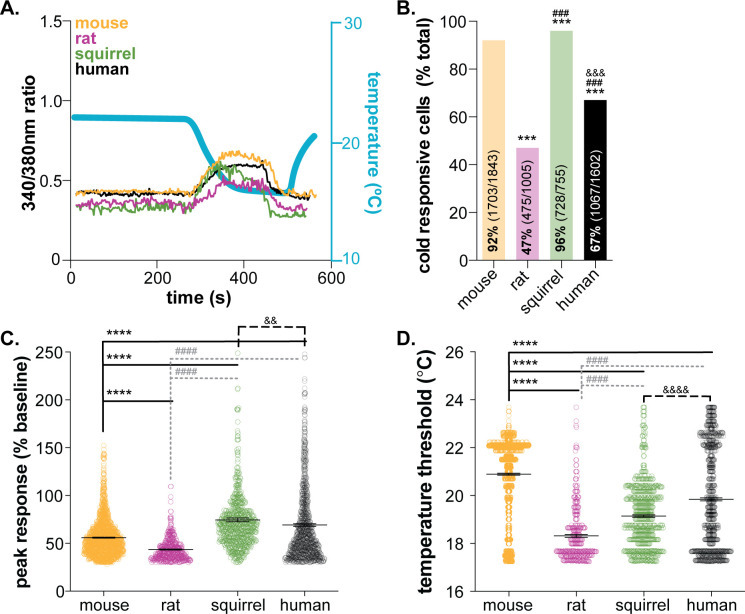
Mammalian keratinocytes respond to temperature decreases.In vitro calcium imaging was performed on primary cultured keratinocytes from the glabrous hindpaw skin of C57BL/6 mice, Sprague Dawley rats, and 13-lined ground squirrels and human breast skin. (A) Representative keratinocytes from all species exhibited a calcium transient upon extracellular buffer cooling (~23°C to 12°C). (B) The greatest proportion of cold-responsive cells was observed in hibernating 13-lined ground squirrel samples. The vast majority of mouse keratinocytes also responded to decreasing temperatures; fewer rat and human keratinocytes responded to cold (Chi-square p<0.0001; Fisher’s Exact tests: ***p<0.001 vs. mouse; ### p<0.001 vs. rat; &&& p<0.001 vs. squirrel; n = 28 mice, four rats, four squirrels, five humans). (C) The peak calcium response to decreasing temperatures varied between species; hibernating 13-lined ground squirrel keratinocytes exhibited the largest calcium transients (75% increase over baseline) and Sprague Dawley rats exhibited the smallest (44% increase over baseline; mouse: 56% increase; human: 69% increase; 1-way ANOVA p<0.0001; Bonferroni’s multiple comparisons: ****p<0.0001 vs. mouse; #### p<0.0001 vs. rat, && p=0.0084 vs. squirrel). (D) The temperature at which keratinocytes responded to cold (>30% increase in Δ340/380) differed between species. Mean temperature thresholds (°C) for mouse: 20.9, rat: 18.3, squirrel: 19.1, human: 19.8 (Kruskal-Wallis test p<0.0001; Dunn’s multiple comparisons: ****p<0.0001 vs. mouse, #### p<0.0001 vs. rat, &&&& p<0.0001 vs. squirrel).